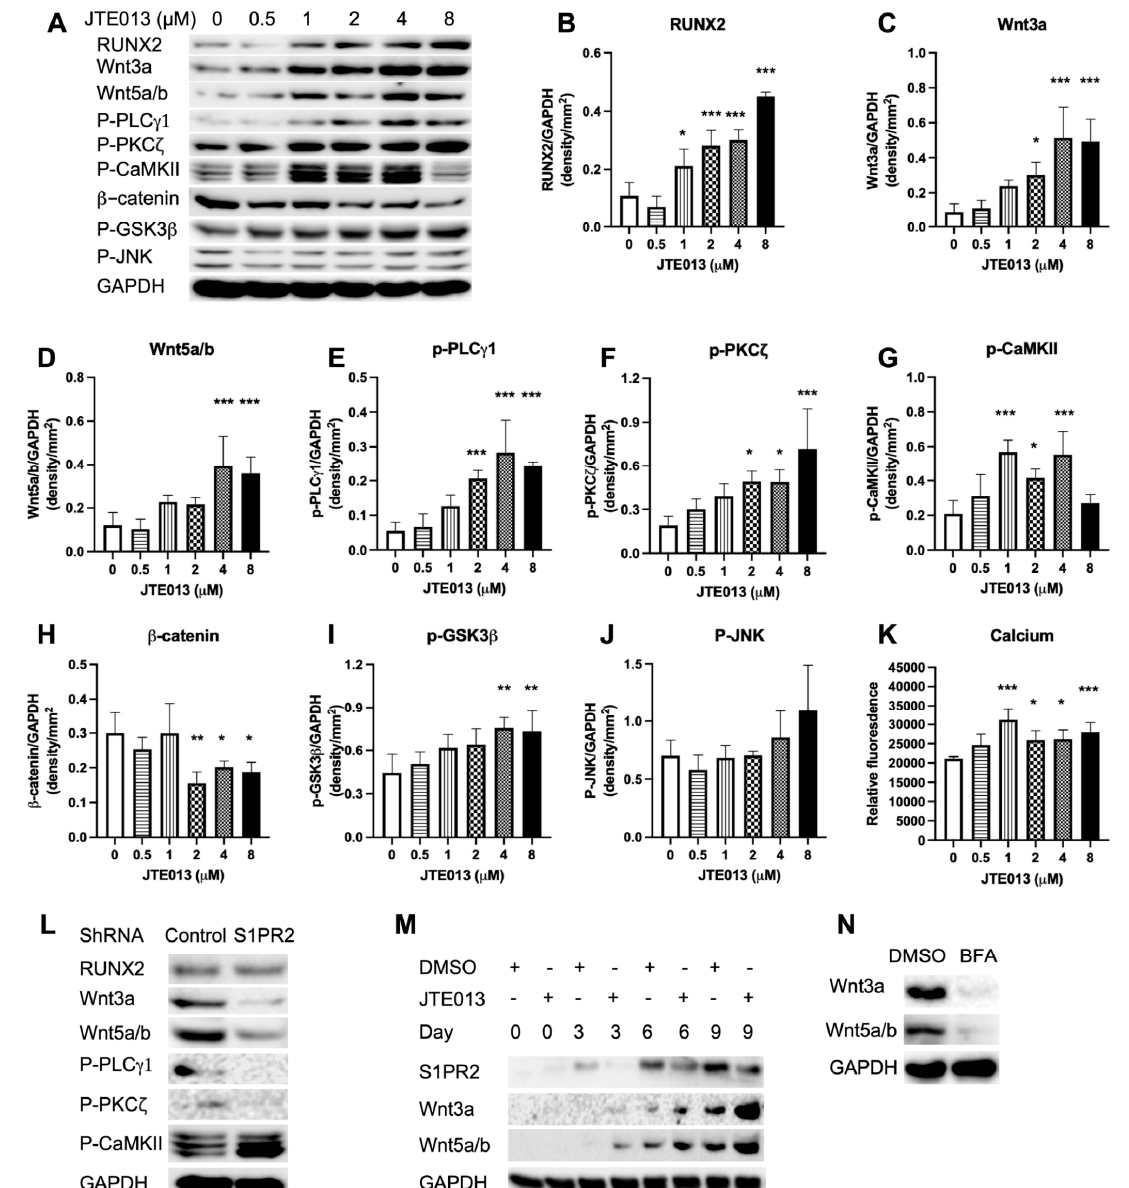
Figure 6. JTE013, but not a S1PR2 shRNA, increased RUNX2 and Wnt/Ca 2+ signaling in murine BMSCs cultured in osteo- genic media. ( A ) RUNX2, Wnt3a, Wnt5a/b, p-PLC γ 1, p-PKC ζ , p-CaMKII, β -catenin, p-GSK3 β , p-JNK, and GAPDH protein expressions in murine BMSCs cultured in osteogenic media with either DMSO or JTE013 (0.5 to 8 μ M) for 9 days. Proteins were harvested 30 min after changing osteogenic media with or without JTE013. Protein densitometry of ( B ) RUNX2, ( C ) Wnt3a, ( D ) Wnt5a/b, ( E ) p-PLC γ 1, ( F ) p-PKC ζ , ( G ) p-CaMKII, ( H ) β -catenin, ( I ) p-GSK3 β , and ( J ) p-JNK was normalized by GAPDH protein expression in murine BMSCs (n = 3, * p < 0.05, ** p < 0.01, *** p < 0.001). ( K ) Ca 2+ level in murine BMSCs treated with DMSO or JTE013 and cultured with osteogenic media for 9 days (n = 5, * p < 0.05, *** p < 0.001). ( L ) RUNX2, Wnt3a, Wnt5a/b, p-PLC γ 1, p-PKC ζ , p-CaMKII, and GAPDH protein expressions in BMSCs treated with a control shRNA or a S1PR2 shRNA and cultured in osteogenic media for 9 days. ( M ) S1PR2, Wnt3a, Wnt5a/b, and GAPDH protein expres- sions in murine BMSCs treated with DMSO or JTE013 (8 μ M) from 30 min to 9 days. ( N ) Wnt3a, Wnt 5a/b, and GAPDH protein expressions in BMSCs treated with DMSO or brefeldin A (BFA, 0.75 μ M) and cultured in osteogenic media for 6 days.